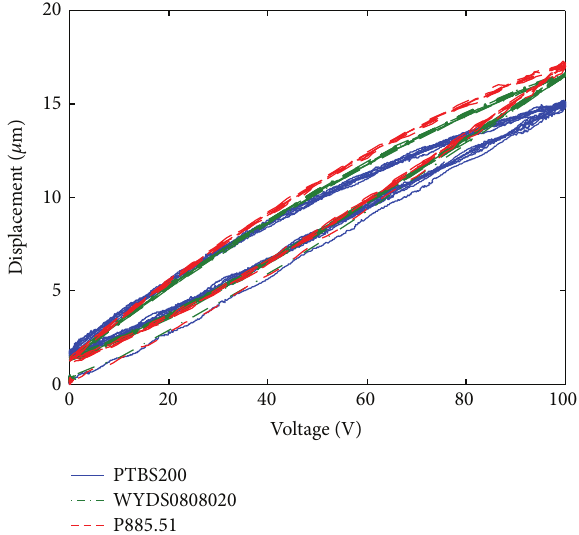
Figure 6: Measured hysteresis curves of the PSAs fabricated by different layering/stacking